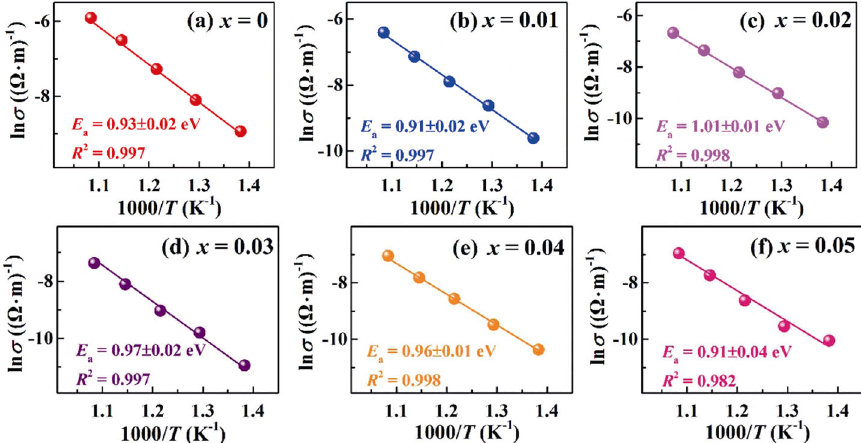
Fig. 7 Arrhenius plots of conductivity versus 1000/ T for (0.99– x )KNNS–CZ– x BNH ceramics: (a) x = 0, (b) x = 0.01, (c) x = 0.02, (d) x = 0.03, (e) x = 0.04, and (f) x =